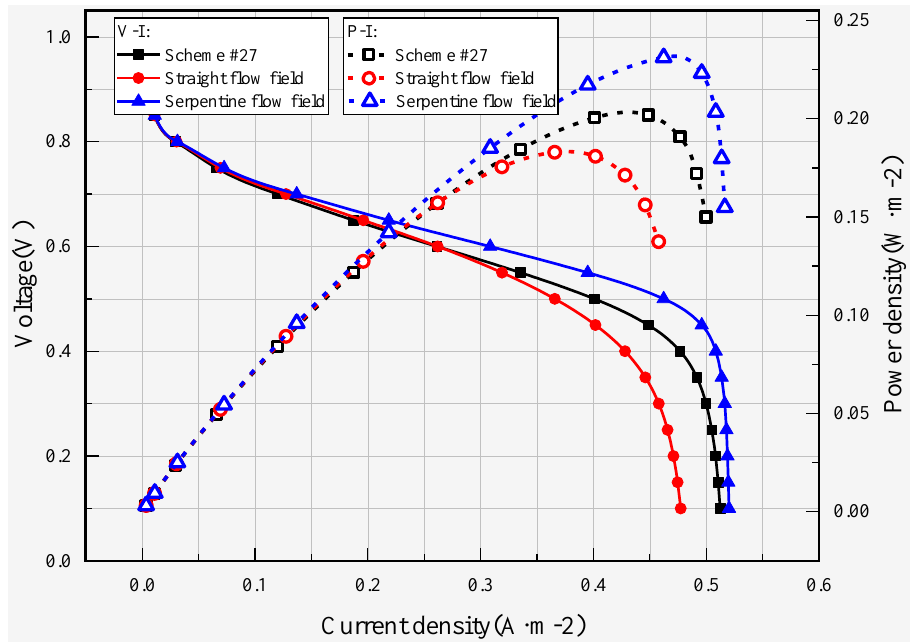
Figure 18. The polarization curves and power density curves of scheme #27, straight flow field and serpentine flow field.